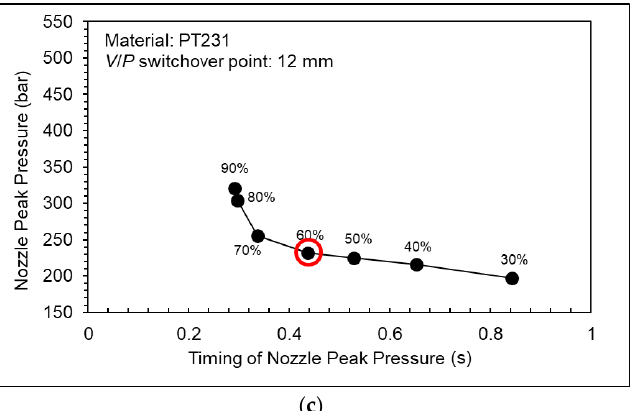
Figure 14. Nozzle peak pressure and timing of nozzle peak pressure at different injection speeds (( a ) 6331 − 8, ( b ) 6331, and ( c ) PT231). (( a ) 6331 − 8, ( b ) 6331, and ( c ) PT231).